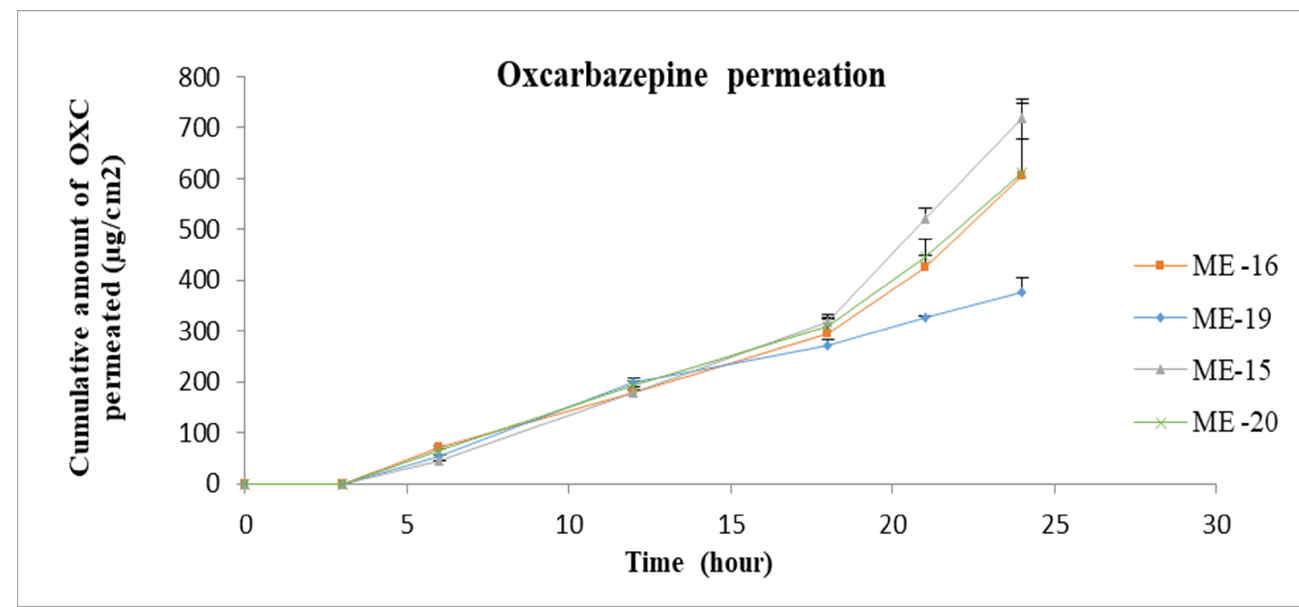
Figure 8 . In vitro cumulative amount of OXC permeated per unit area versus time across the human cadaver skin. Each point represents the mean ± S.D. of three replicates in the absence of multiple donors. ME15-10%OA, 30%T80, 30%TRC, 30%Water. ME16-10%OA, 30%TRC, 30%LS, 30%Water.